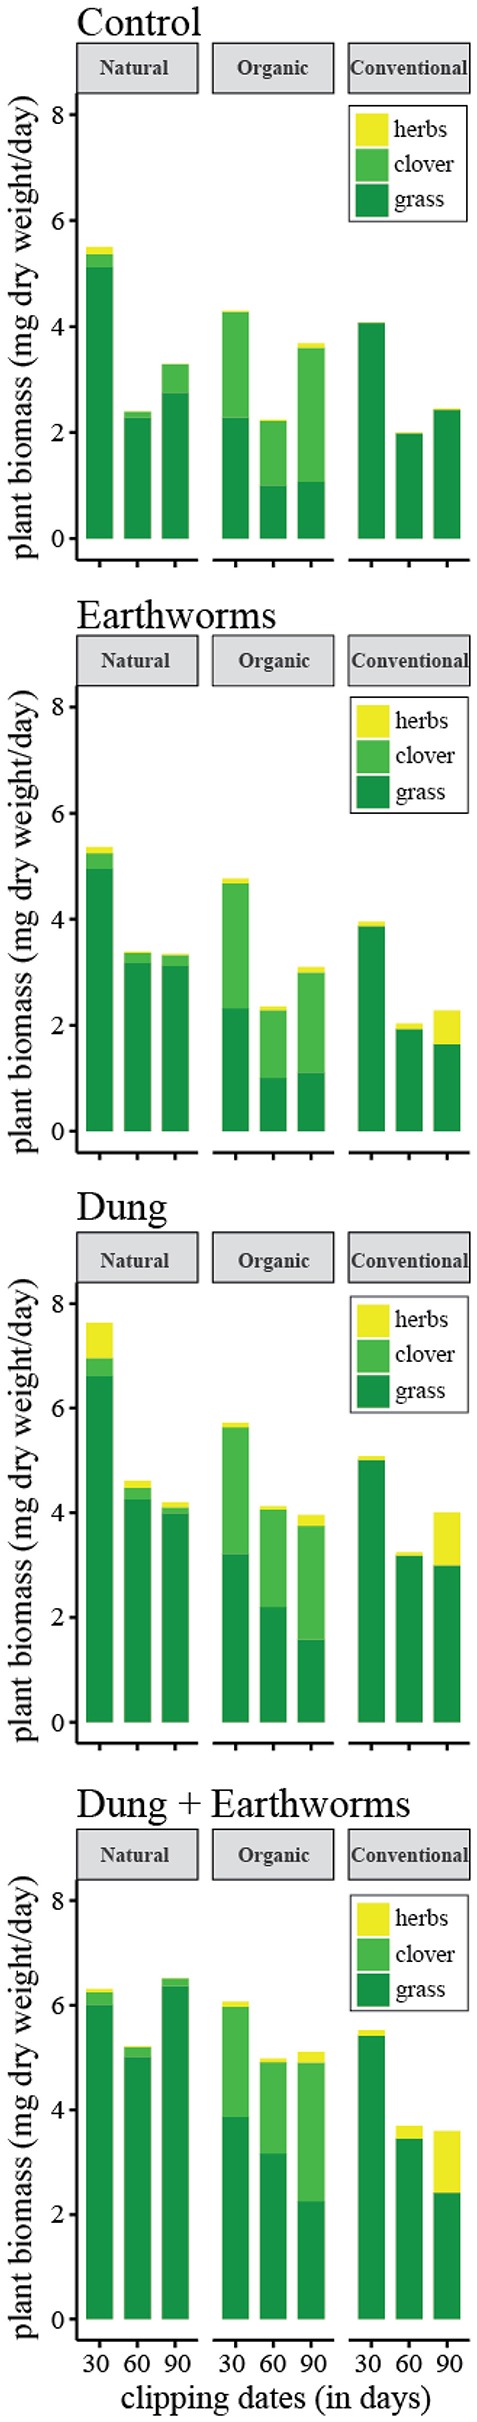
Plant productivity in the soil cores throughout the experiment expressed in mg of plant dry weight produced per day. Plants were clipped three times every 30 days and categorized as grass, clover, and herbs before drying. Each bar represents the mean plant productivity for soil cores of the same soil management and treatment.